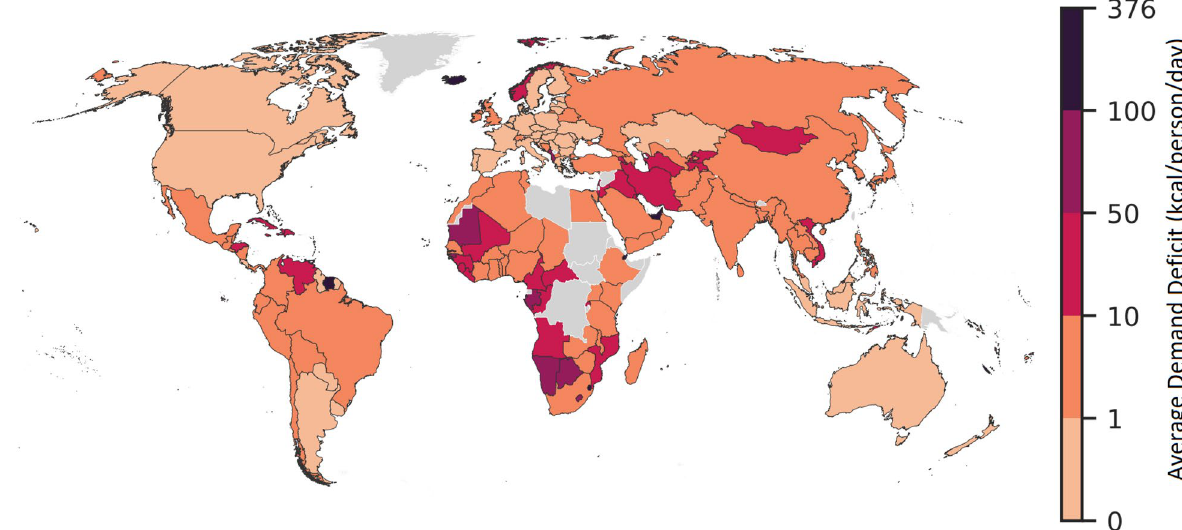
Figure 1. Exposure to external shocks: average demand deficit. The map reports the final demand deficit (in terms of kcals/person/day) averaged over a series of N simulations that reproduce, one at the time and for all the countries in the network, the propagation of shock associated to a 30% drop of domestic food production. The diffusion of the shock is simulated setting α = 1 , but similar results can be obtained imposing α = 0.5 and α = 0 . The map is generated by using GeoPandas 37 with Natural Earth data